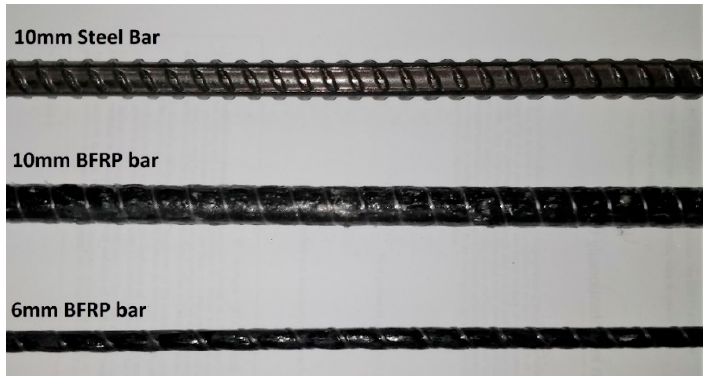
Figure 1 . Basalt FRP and steel pull-out bars used in this